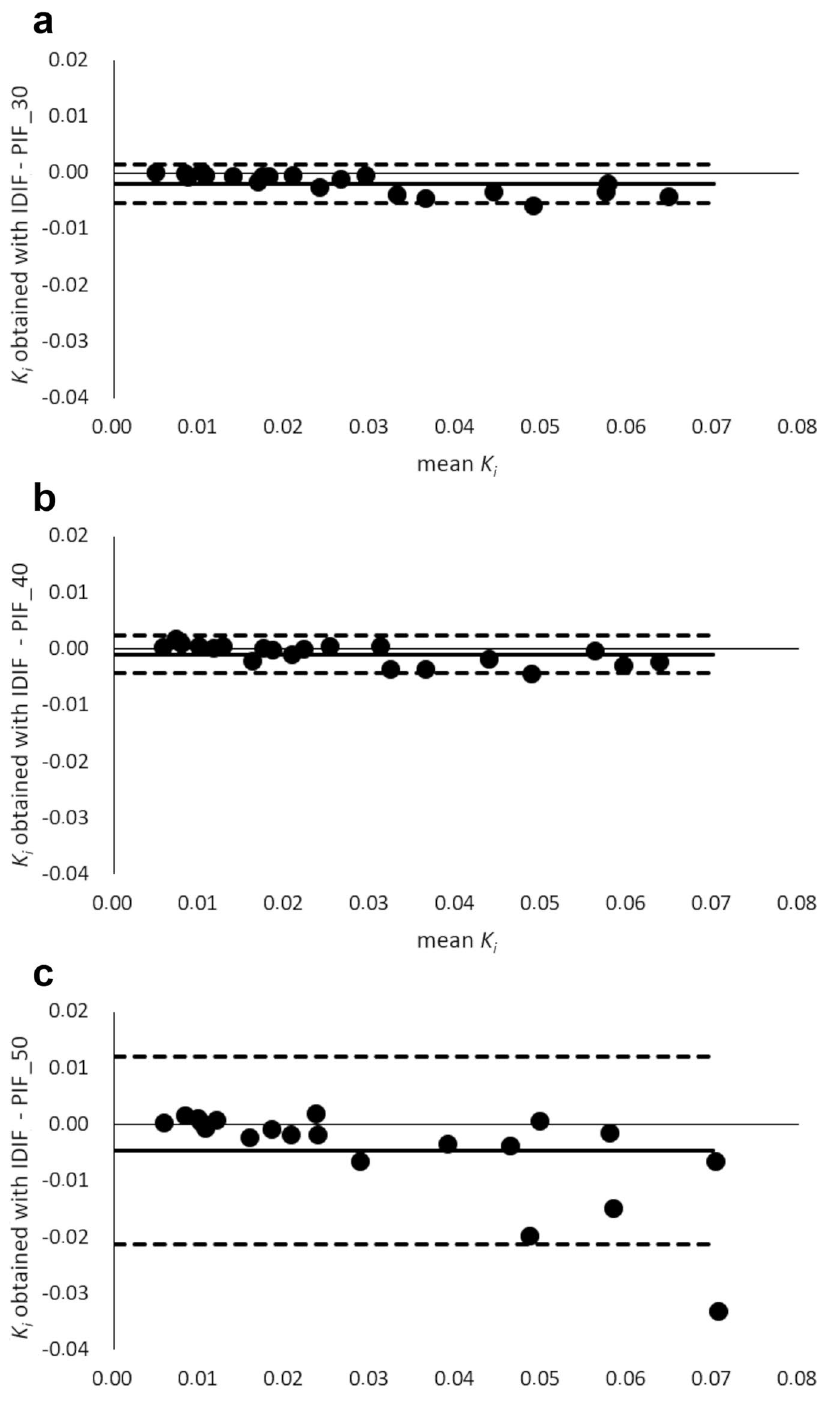
Fig. 4 Bland–Altman plot of lesion K i differences obtained with the IDIF minus the PIF scaled to the scan time interval at 30–60 min p.i. (PIF_30) ( a ), and the PIF scaled to the IDIF at shorter scan time intervals p.i. (PIF_40 and PIF_50) ( b , c ). To illustrate differences between the comparisons, the scales on the vertical axes are matched in the subfigures. For readability purposes, these Bland–Altman plots with modified axes are shown in Additional file 1: Fig.